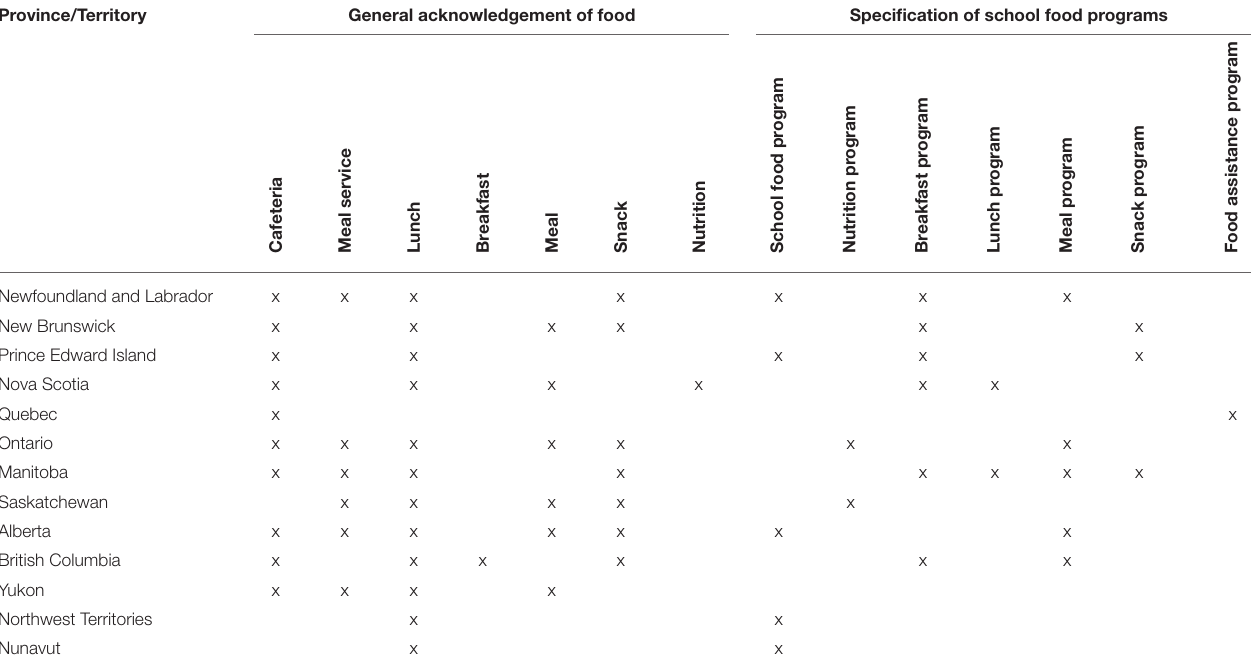
TABLE 2 | Acknowledgement of (and difference in terminology regarding) “food”’ in school reopening